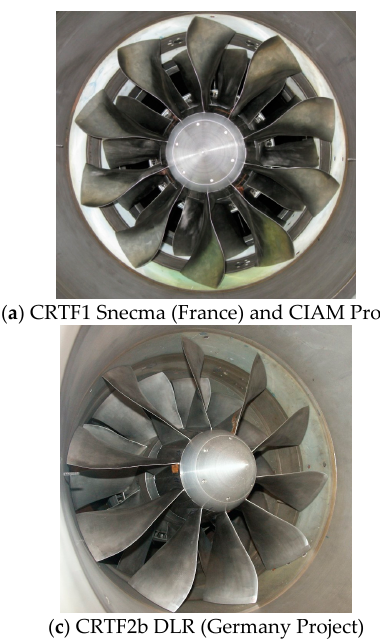
Figure 6. Model fans developed and tested under the European VITAL project at the C-3A test facility with the anechoic chamber. ( a ) CRTF1; ( b ) SRF; ( c ) CRTF2b; ( d ) CRTF2a. with the anechoic chamber. ( a ) CRTF1; ( b ) SRF; ( c ) CRTF2b; ( d )